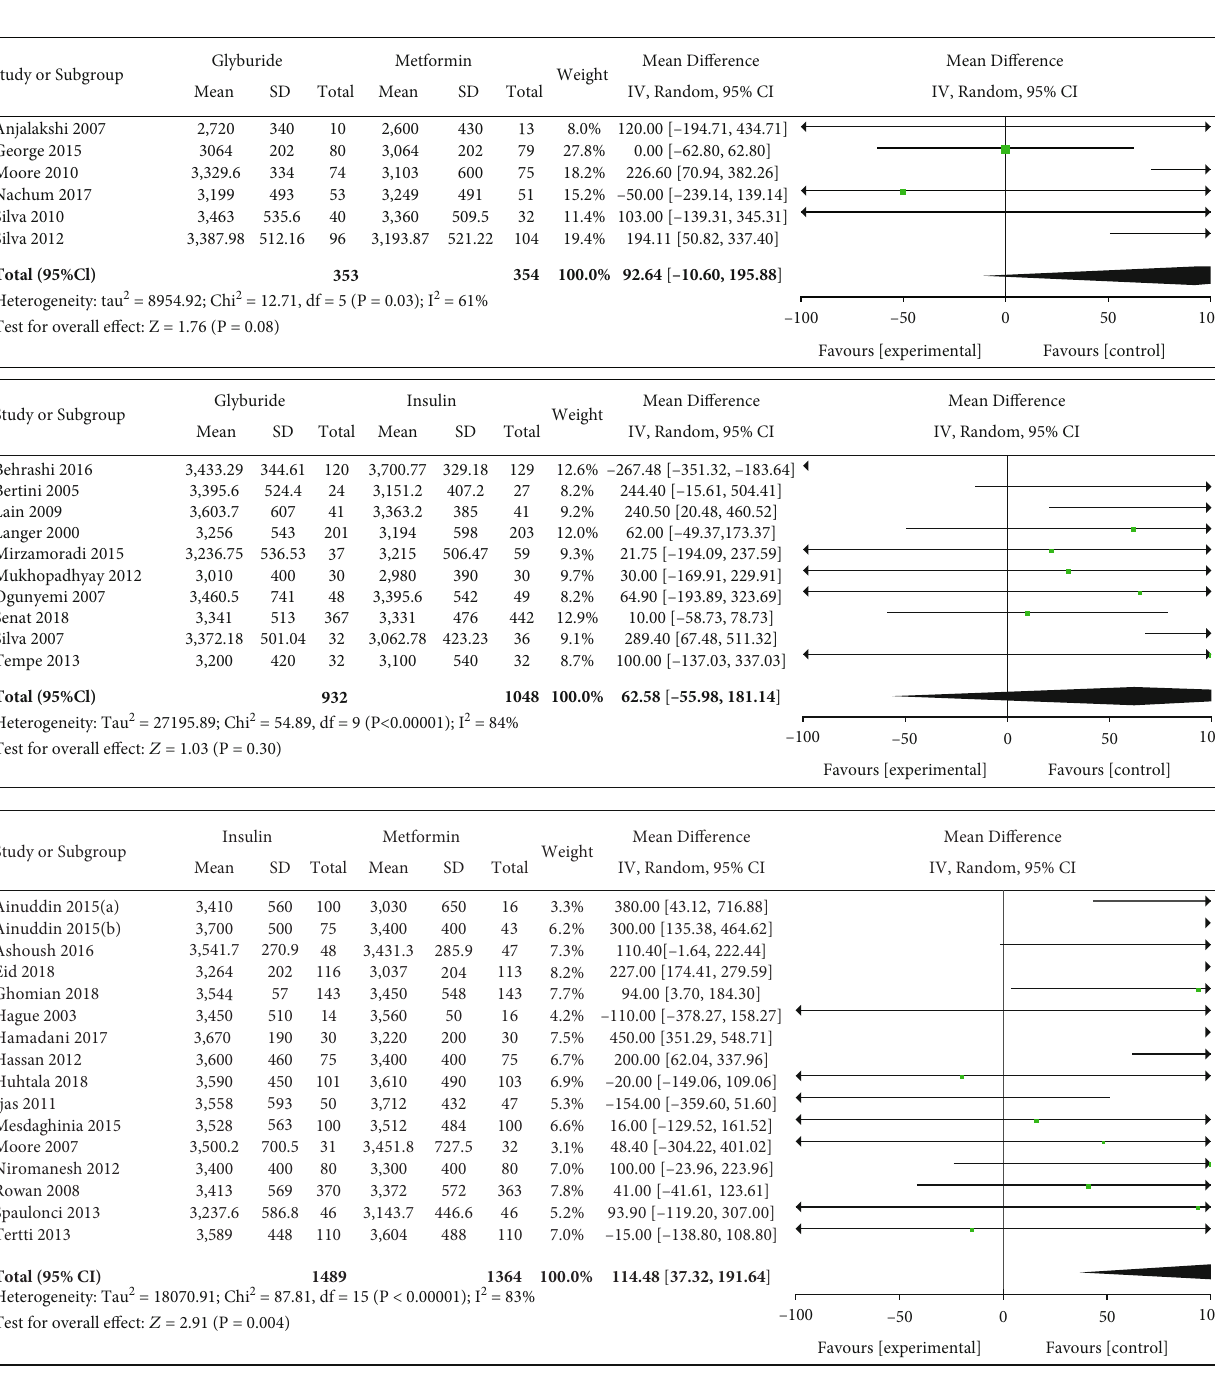
100 Test for overall effect: Z = 2.91 (P = 0.004)